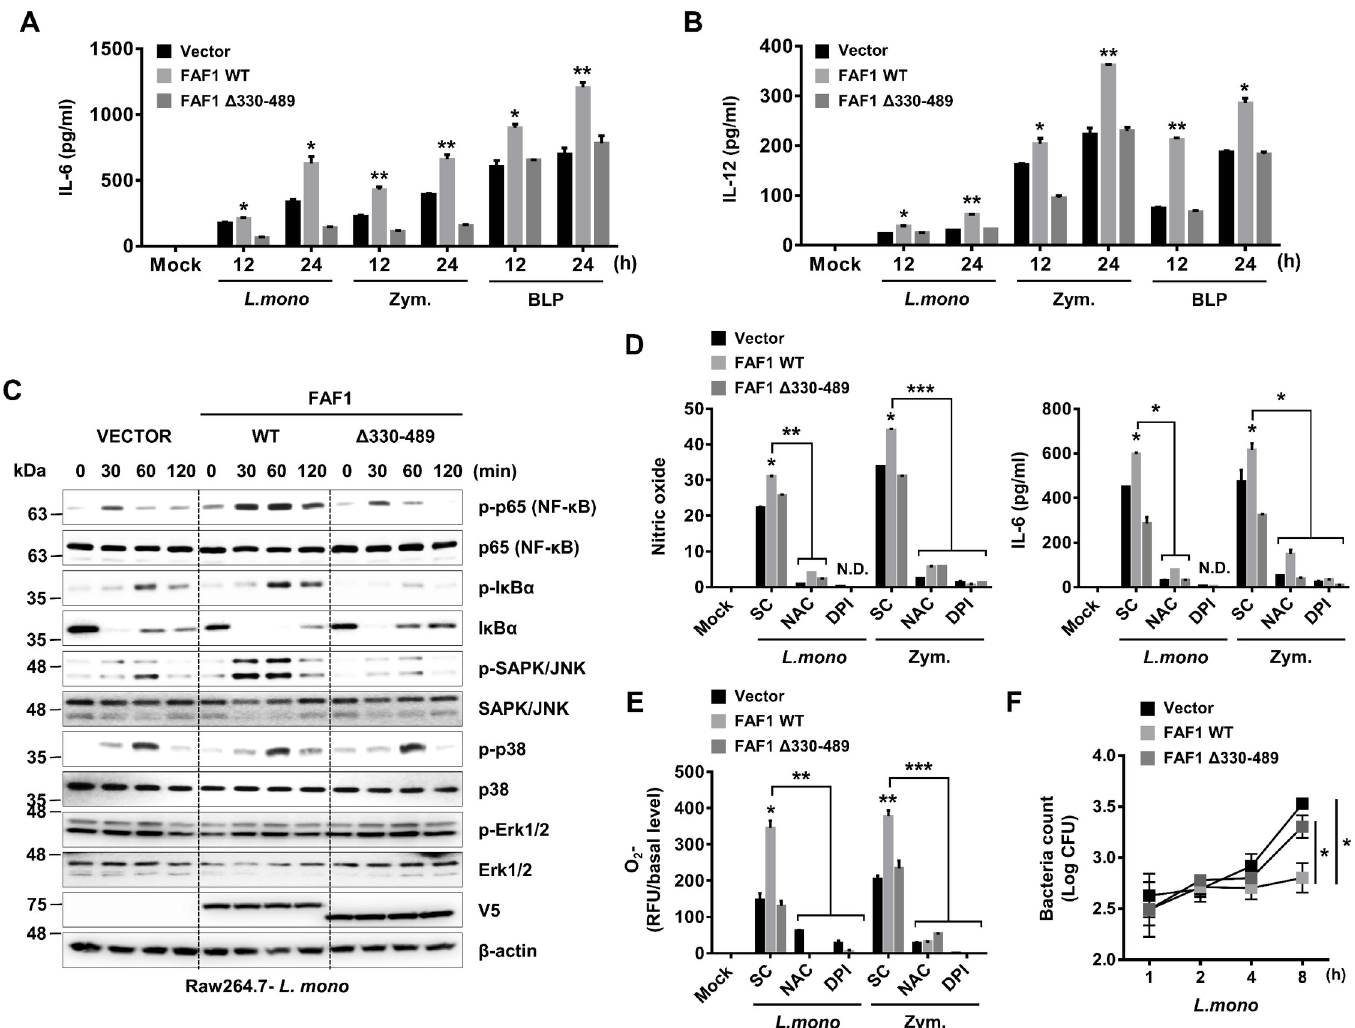
Fig 5. Deletion of amino acids 330–489 in FAF1 attenuates ROS generation and inflammatory responses against L . monocytogenes infection. (A and B) Raw264.7 cells containing empty vector or V5-tagged FAF1 wild-type or FAF1 Δ 330–489 were infected with L . monocytogenes (MOI = 1) or treated with zymosan (100 μ g/ml) or BLP (100ng/ml) for the indicated times, and measured for levels of IL-6 (A) and IL-12 (B) by ELISA. (C) Raw264.7 cells containing empty vector or V5-tagged FAF1 wild- type or FAF1 Δ 330–489 were infected with L . monocytogenes (MOI = 1) for the indicated times, and then subjected to immunoblotting with the phosphorylated and total forms of p65, I κ B α ,JNK, p38, p42/p44 MAPK, V5 or β -actin. (D and E) Raw264.7 cells containing empty vector or V5-tagged FAF1 wild-type or FAF1 Δ 330–489 were infected with L . monocytogenes (MOI = 1) or treated with zymosan w/ or w/o NAC or DPI. At 18hrs, the supernatants were analyzed for NO production or IL-6 secretion (D). At 30min, O 2 - production was determined by DHE red fluorescent dye (E). (F) Raw264.7 cells containing empty vector or V5-tagged FAF1 wild-type or FAF1 Δ 330– 489 were infected with L . monocytogenes (MOI = 0.1) for the indicated times, and washed with PBS. Then, cells were lysed by Triton X-100, and intracellular bacteria were determined by CFU titration. Data are representative of two (C-F) or three (A, B) independent experiments. Error bars, mean ± SD. � P < 0.05, �� P < 0.01, ��� P < 0.001 (Student‘s t -test), compared to cells expressing empty vector or FAF1 Δ 330–489. N.D., no